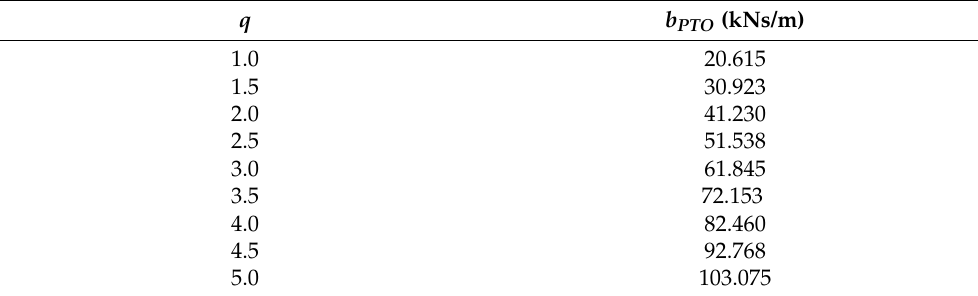
(cid:1) (cid:0) ω = ω ISO , q = n 3 33 (cid:0) (cid:1) ω = ω ISO used for determining b PTO ( ω ) for the n 3 33